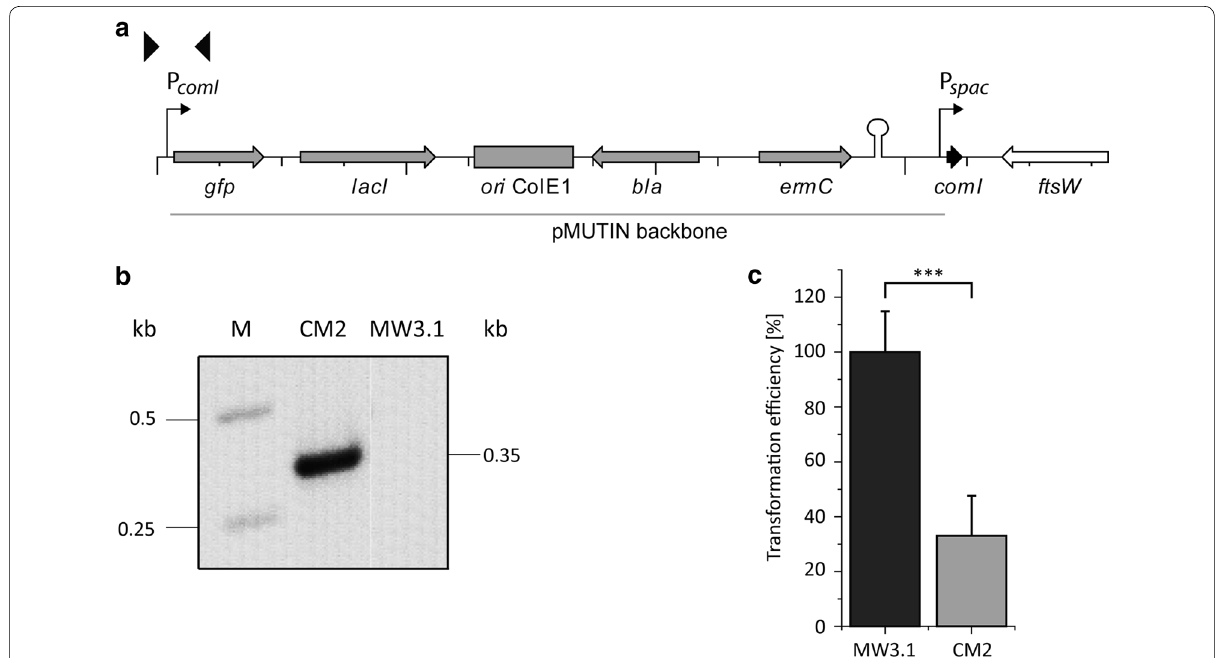
Fig. 3 Overexpression of comI and its effect on induced genetic competence. a Schematic illustration of the genomic region of the pMUTIN‑comI integrant B. licheniformis CM2. Open reading frames are shown as arrows , the direction of which corresponds to the transcriptional orientation. Screening primers are denoted as black triangles , promoters are depicted as angled arrows and the t1t2t0‑terminator is shown as a hairpin‑structure. comI , encoding the putative competence inhibitor ComI DSM13 ; ftsW , encoding a cell‑division protein; gfp , green fluorescent protein gene; lacI , encodes the repressor protein LacI; ori ColE1, origin of replication; bla , encodes ampicillin resistance; ermC , erythromycin resistance gene. b Veri‑ fication of the pMUTIN‑comI insertion via PCR with the screening primers comI13f_KpnI and GFPseqr1 and gel electrophoresis. c Transformation efficiencies for B. licheniformis MW3.1 and B. licheniformis CM2 obtained by induced genetic competence using chromosomal DNA of B. licheniformis ∆ spoIV (Hoffmann et al. 2010) to obtain uracil prototrophy (n 3). Induction of P spac was achieved by addition of IPTG to the cultivation medium to = a final concentration of 100 µM. Transformation efficiencies for the wild type (MW3.1) were arbitrarily set as 100%. Data are given as mean SD of 3 ± independent experiments. ***p <